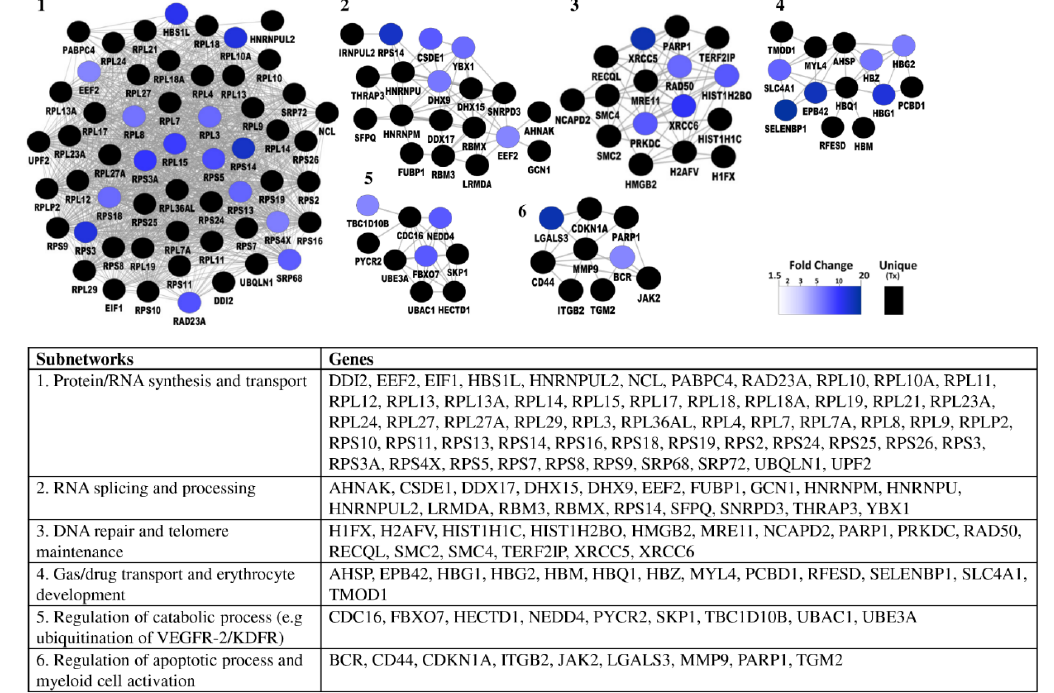
Figure 5. Protein–protein networks of significantly upregulated platelet proteins after the start of antitumor treatment. Platelet protein content was compared in paired samples of patients with cancer ( n = 3) which were drawn pretreatment and after initiation of antitumor treatment. ( p < 0.05, fold change ≥ 5). The networks were generated with cytoscape app “ClusterONE”.